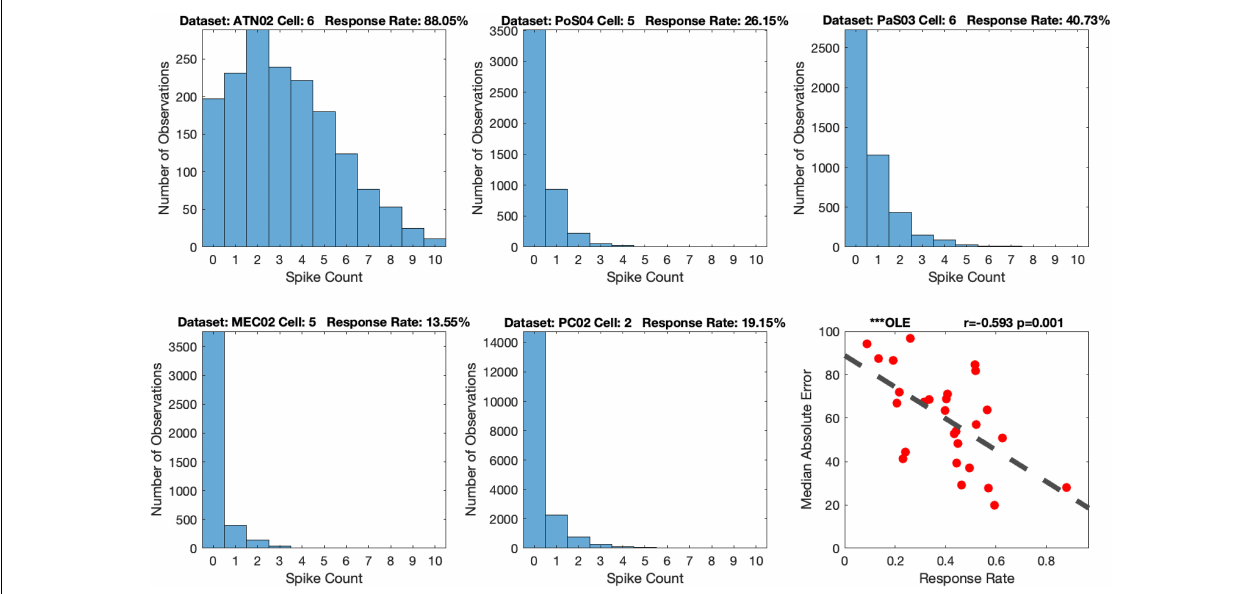
FIGURE 12 | Example histograms of spike counts (top three, bottom left and bottom middle) , and an example Median Absolute Error (MAE) vs. response rate scatterplot (bottom right) : The dataset’s label and response rate are listed in the title. The example scatterplot illustrates the modest relationship between response rate and decoding accuracy. Scatterplots for all the 12 methods are shown in Supplementary Material S12 . The dashed line in the scatterplot is the fitted linear regression. Optimal Linear Estimator (OLE).